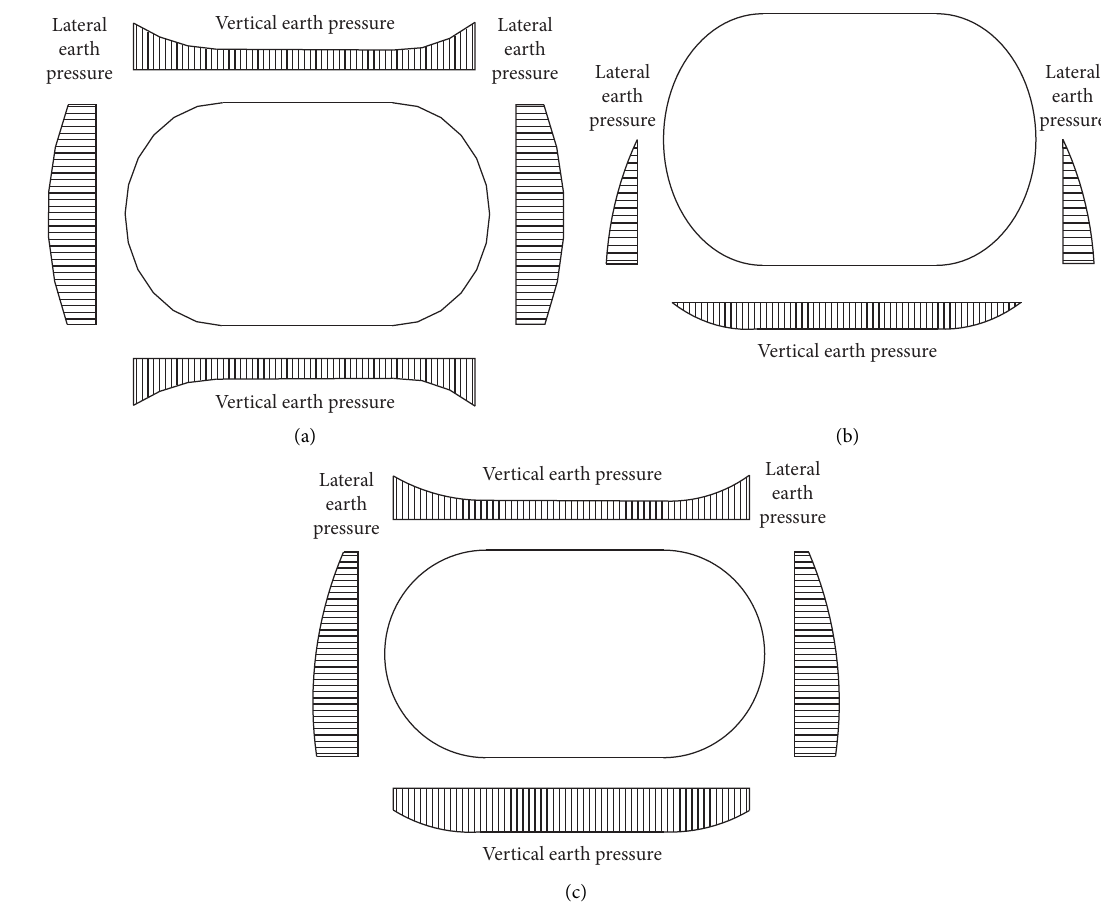
Figure 7: Earth pressure imposed on the surface of shield